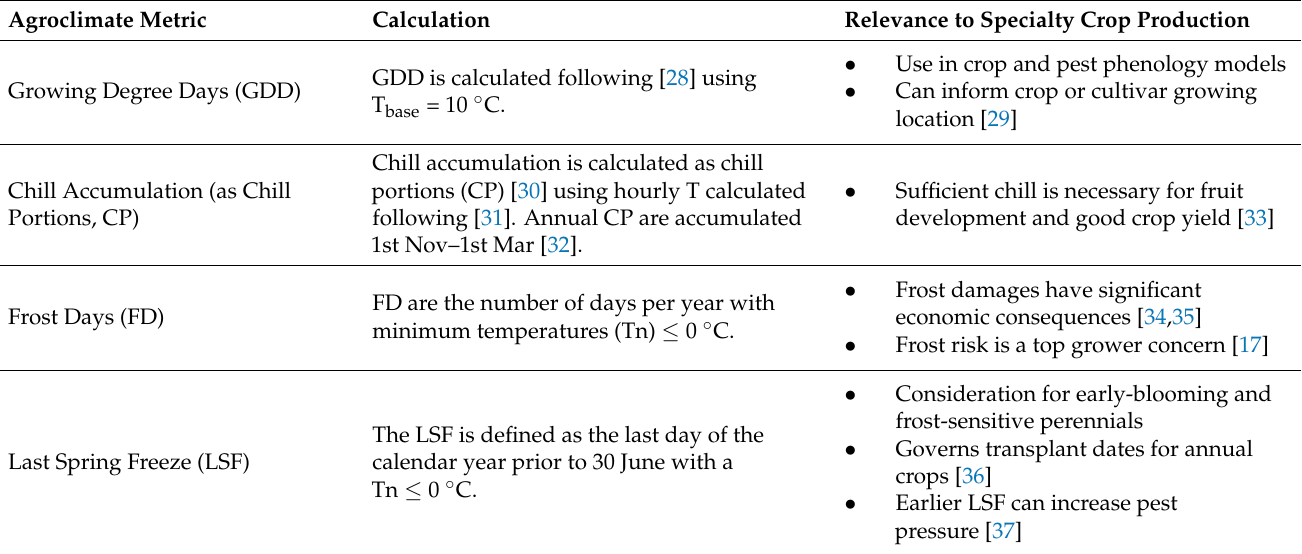
Table 1. The 12 agroclimate metrics selected for this analysis, how they are calculated or defined, and their relevance to specialty crop production. Formulae for GDD, CP, and ETo are provided in Table